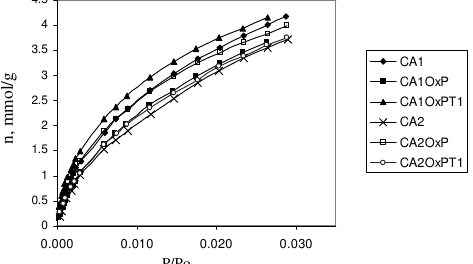
Figure 2. Carbon dioxide desorption isotherms at 273 K.